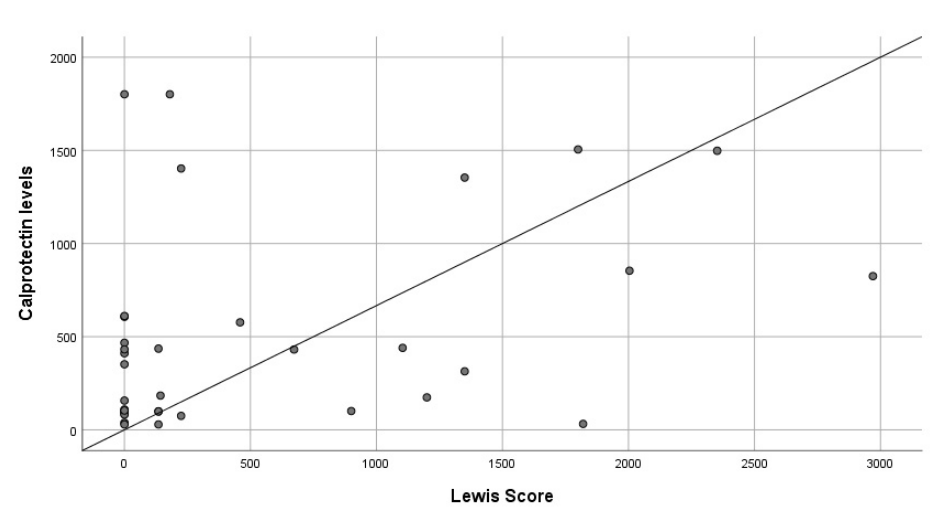
Figure 2. Correlation between fecal calprotectin levels and severity of inflammation measured with Lewis score.